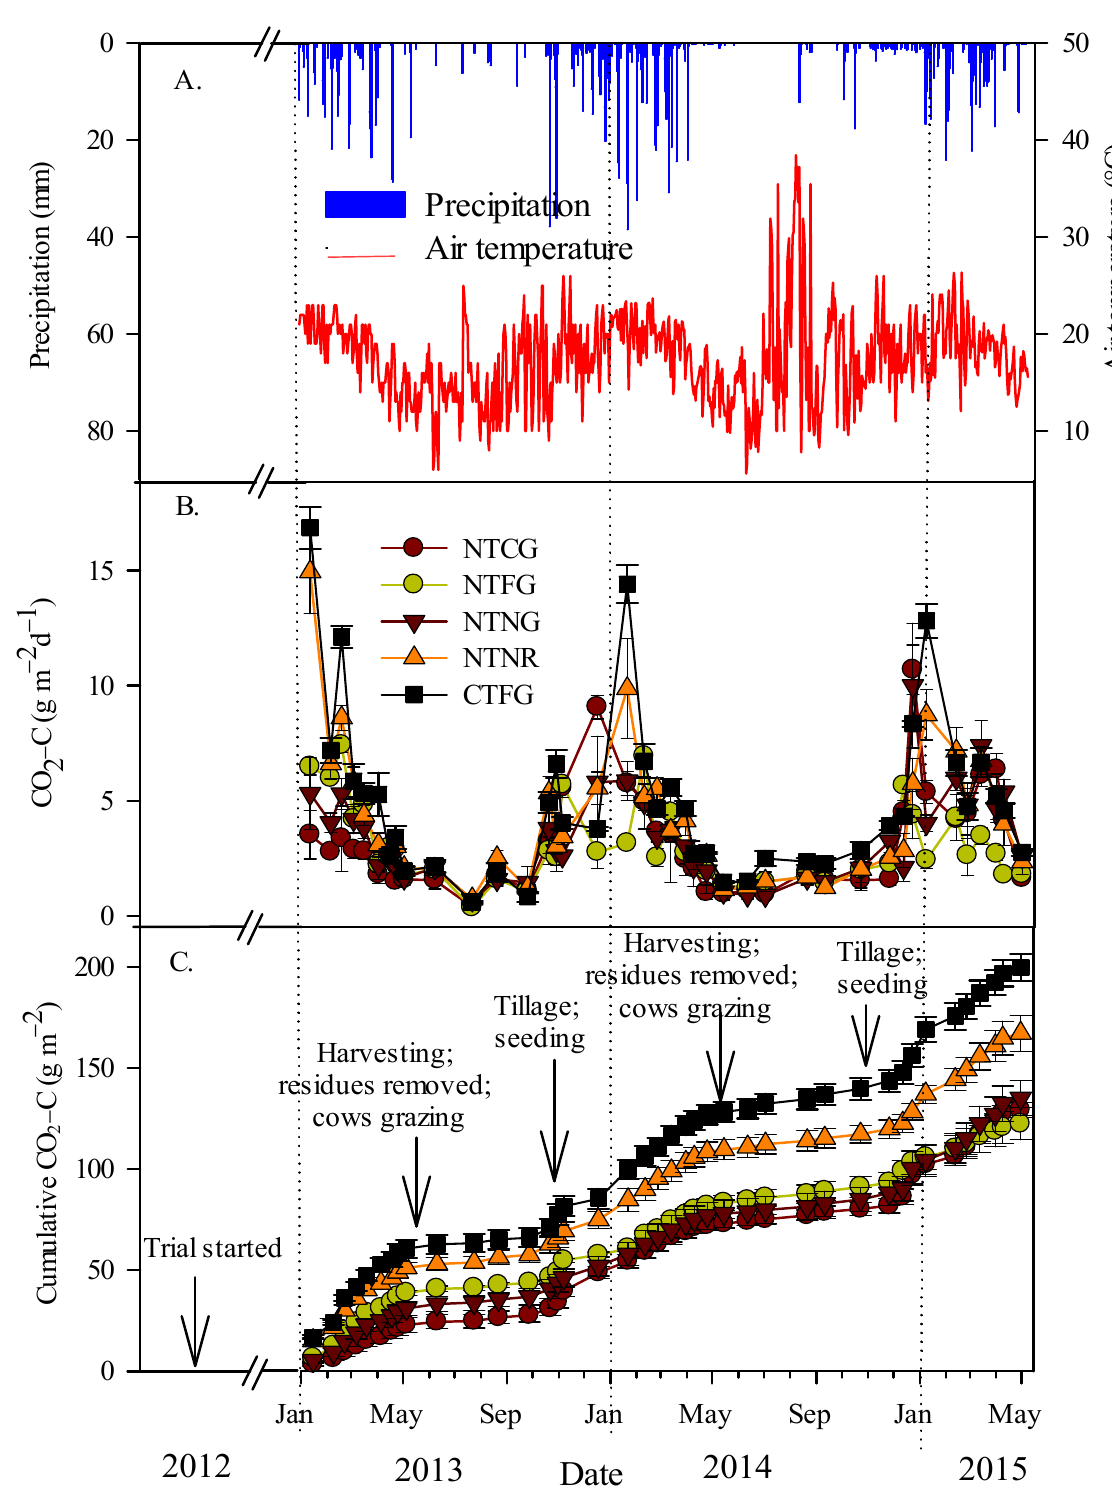
Figure 1. Precipitation and air temperature ( A ), daily fluxes ( B ) and cumulative ( C ) of gross soil CO 2 -C efflux (g CO 2 -C m − 2 ) conventional tillage with free grazing (CTFG), no-tillage with free grazing (NTFG), no-tillage with no grazing (NTNG), no-tillage without crop residue mulching (NTNR) and no-tillage with controlled grazing (NTCG). Error bars represent the standard error of the mean. N =